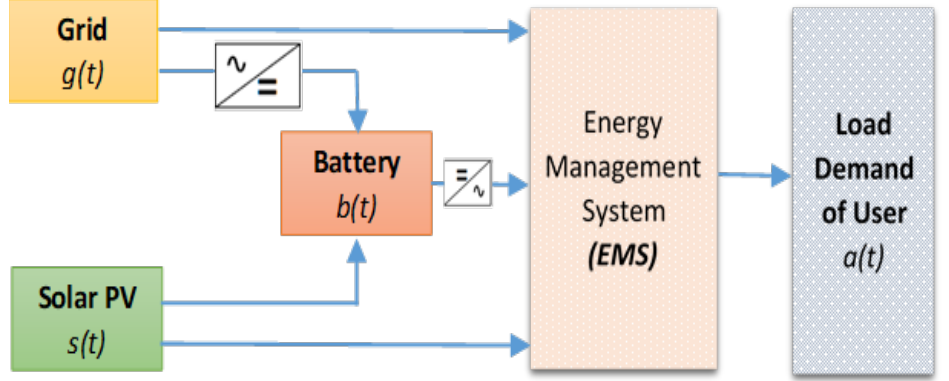
Figure 1. Off-grid unidirectional model.